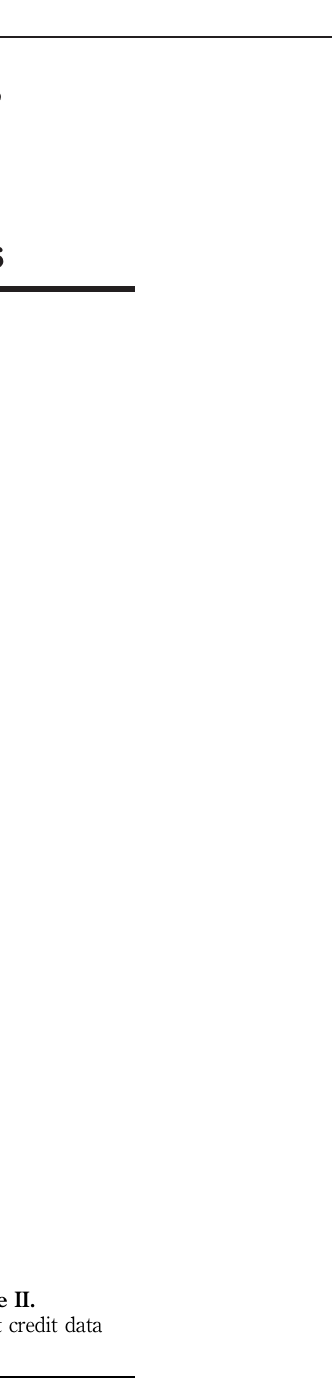
Table II. Direct credit data